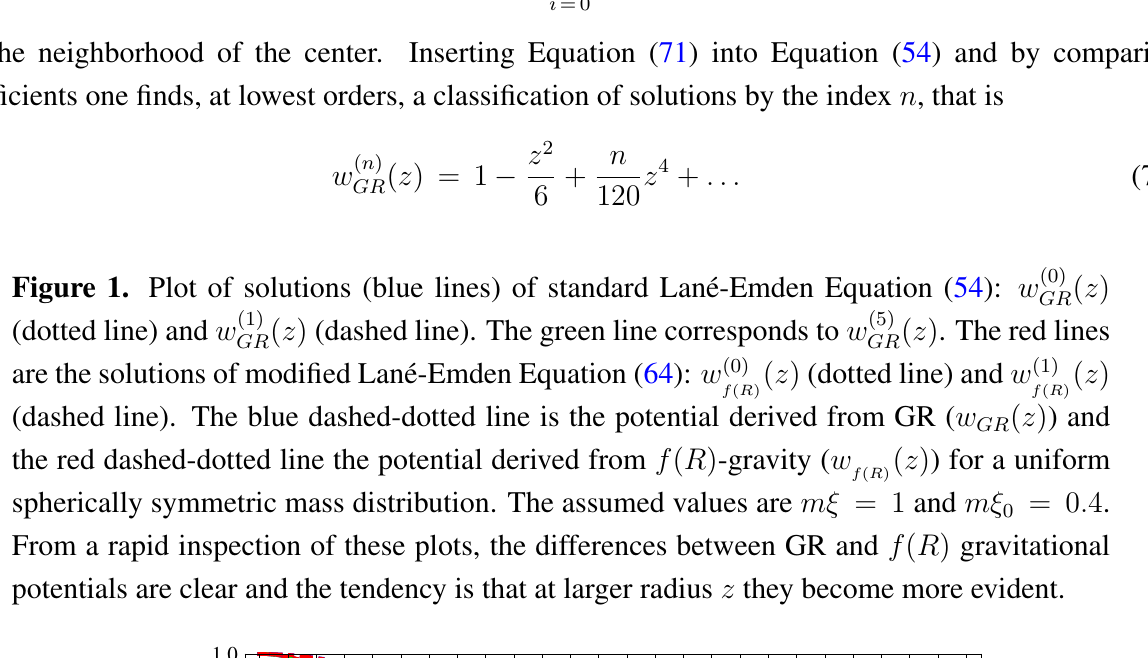
Figure 1. Plot of solutions (blue lines) of standard Lané-Emden Equation (54): w (0) ( z ) (dashed line). The green line corresponds to w (5) (dotted line) and w (1) GR are the solutions of modified Lané-Emden Equation (64): w (0) (dashed line). The blue dashed-dotted line is the potential derived from GR ( w the red dashed-dotted line the potential derived from f ( R ) -gravity ( w spherically symmetric mass distribution. The assumed values are mξ = 1 and mξ